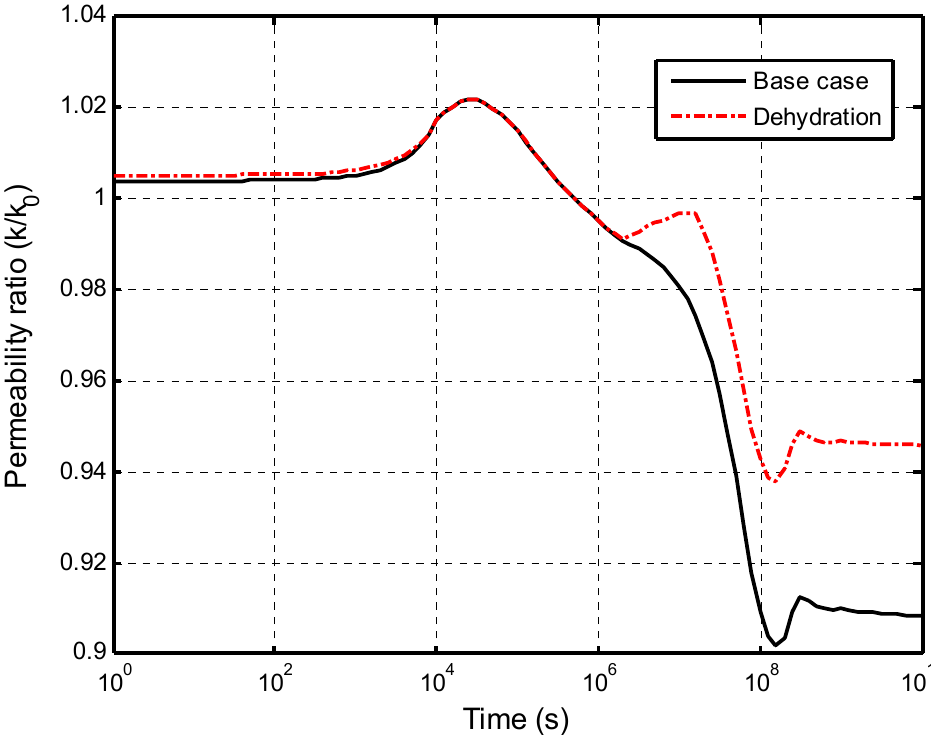
Figure 11. Comparations of permeability ratio at the observation point.